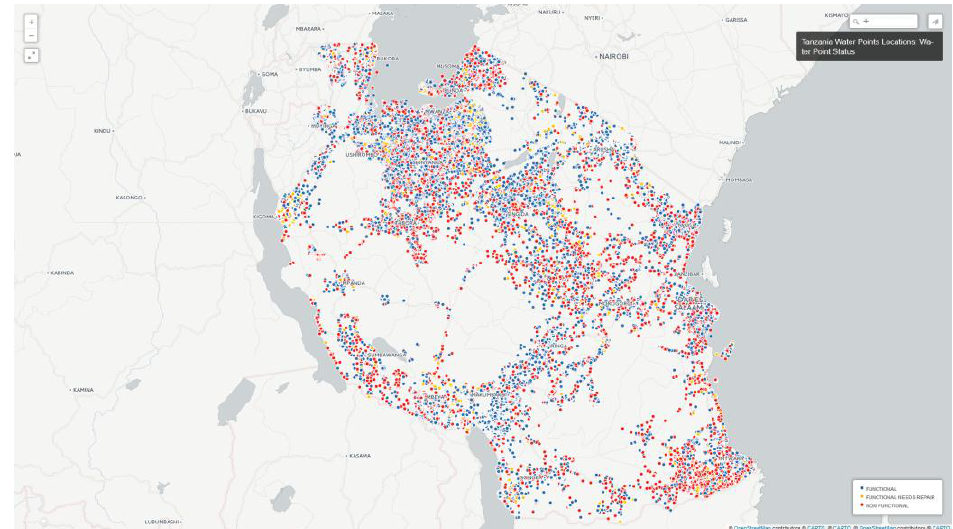
Figure 2. The current Water Dashboard of the MoW—”Seeing” the functionality status of all rural water points—Functional ( blue ), Non Functional ( red ), Functional Needs Repair ( yellow ) [16].